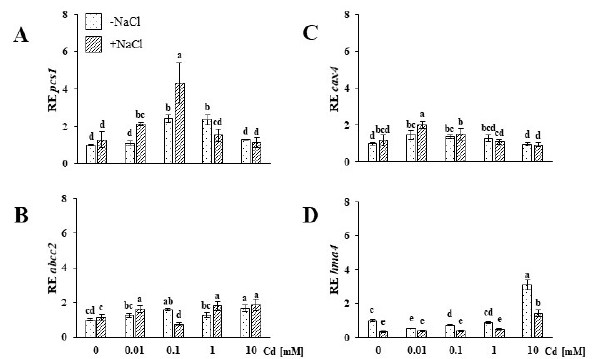
Figure 3. Expression of phytochelatin synthase 1, pcs1 ( A ), ATP-binding cassette type c 2, abcc2 ( B ), cation exchanger 4, cax4 ( C ), and heavy metal ATPase 4, hma4 ( D ) genes in the shoots of soil-grown NaCl-untreated ( − NaCl) and salt-stressed ( + NaCl) Mesembryanthemum crystallinum plants subjected to concentrations of 0.01, 0.1, 1, 10 mM Cd and control (0.0 mM). Different letters above the bars indicate statistically significant differences at P ≤ 0.05 by Duncan’s post hoc test ( N = 4, mean value ±SD).